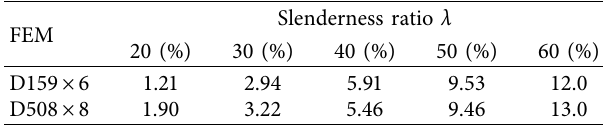
Table 4: Effect of residual stresses on overall buckling factor φ .